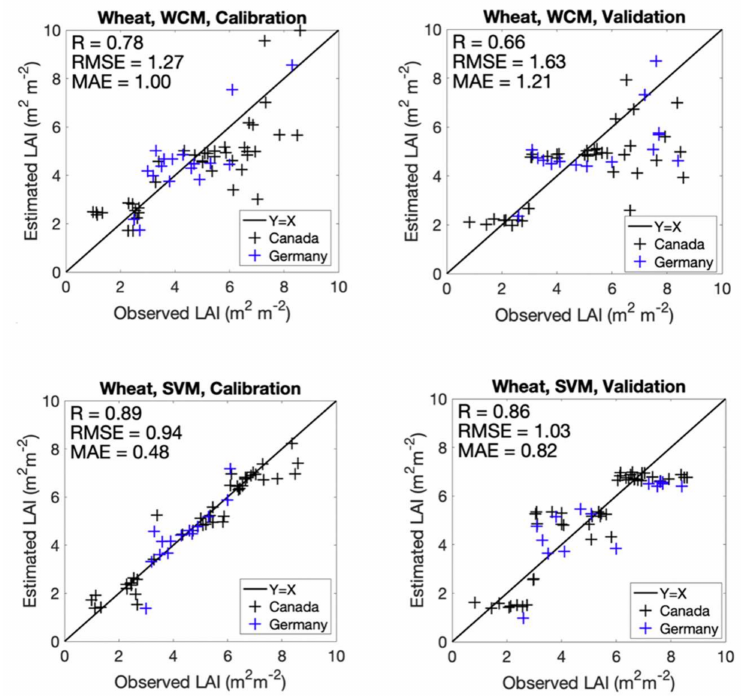
Figure 6. The calibration and validation results for wheat for two JECAM sites (Canada and